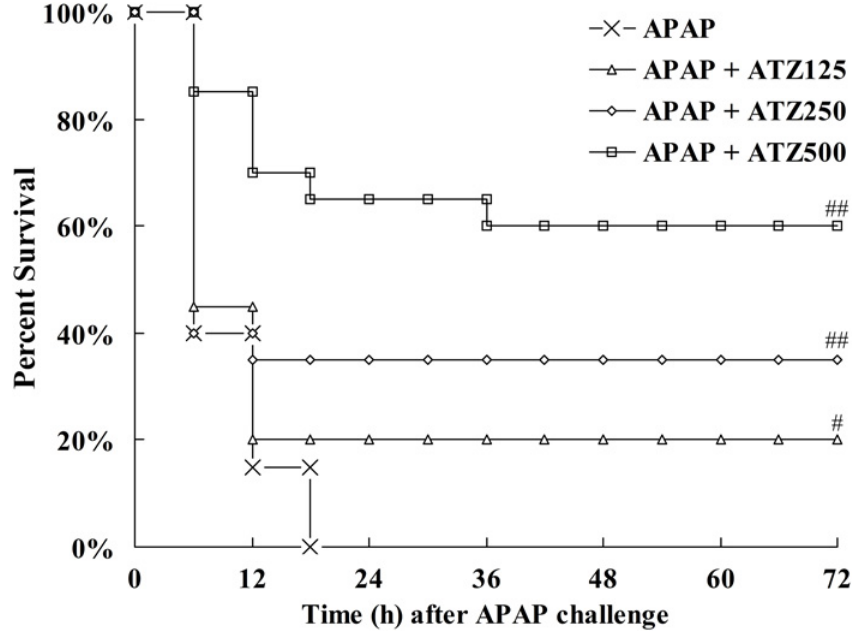
Fig 3. Pretreatment with ATZ decreased the mortality induced by APAP. Mice were pretreated with vehicle or various doses of ATZ (125 mg/kg, 250 mg/kg, 500 mg/kg) before APAP exposure. Survival was monitored and the percent survival rate was expressed as Kaplan-Meier survival curves (n = 20). # P < 0.05, ## P < 0.01, as compared with the APAP group.